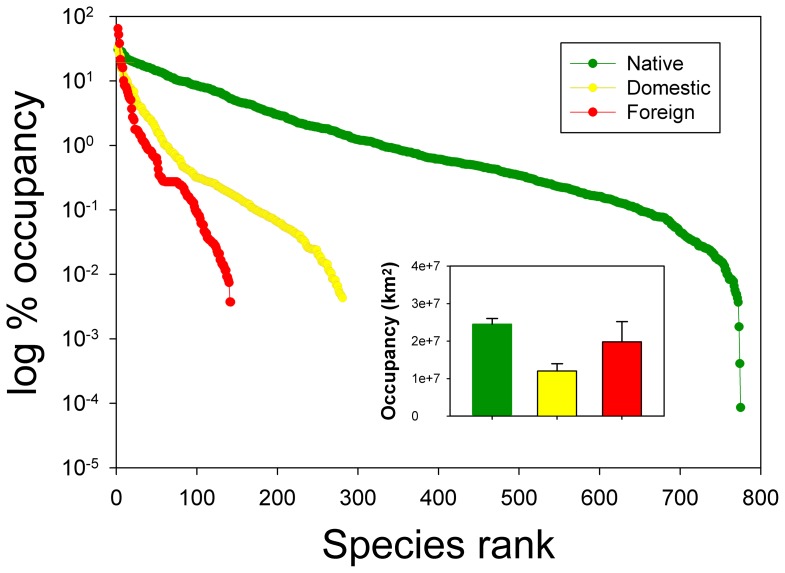
Species rank curves for the three groups (natives, domestic exotics, and foreign exotics) using the distribution data at sub-watersheds level in the contiguous United States.Although foreign exotics still had smaller distribution than natives (but higher than domestic exotics; see inserted panel [mean ± SE]), the variation among species was much larger which was in agreement with the occupancy curves of the three species groups.